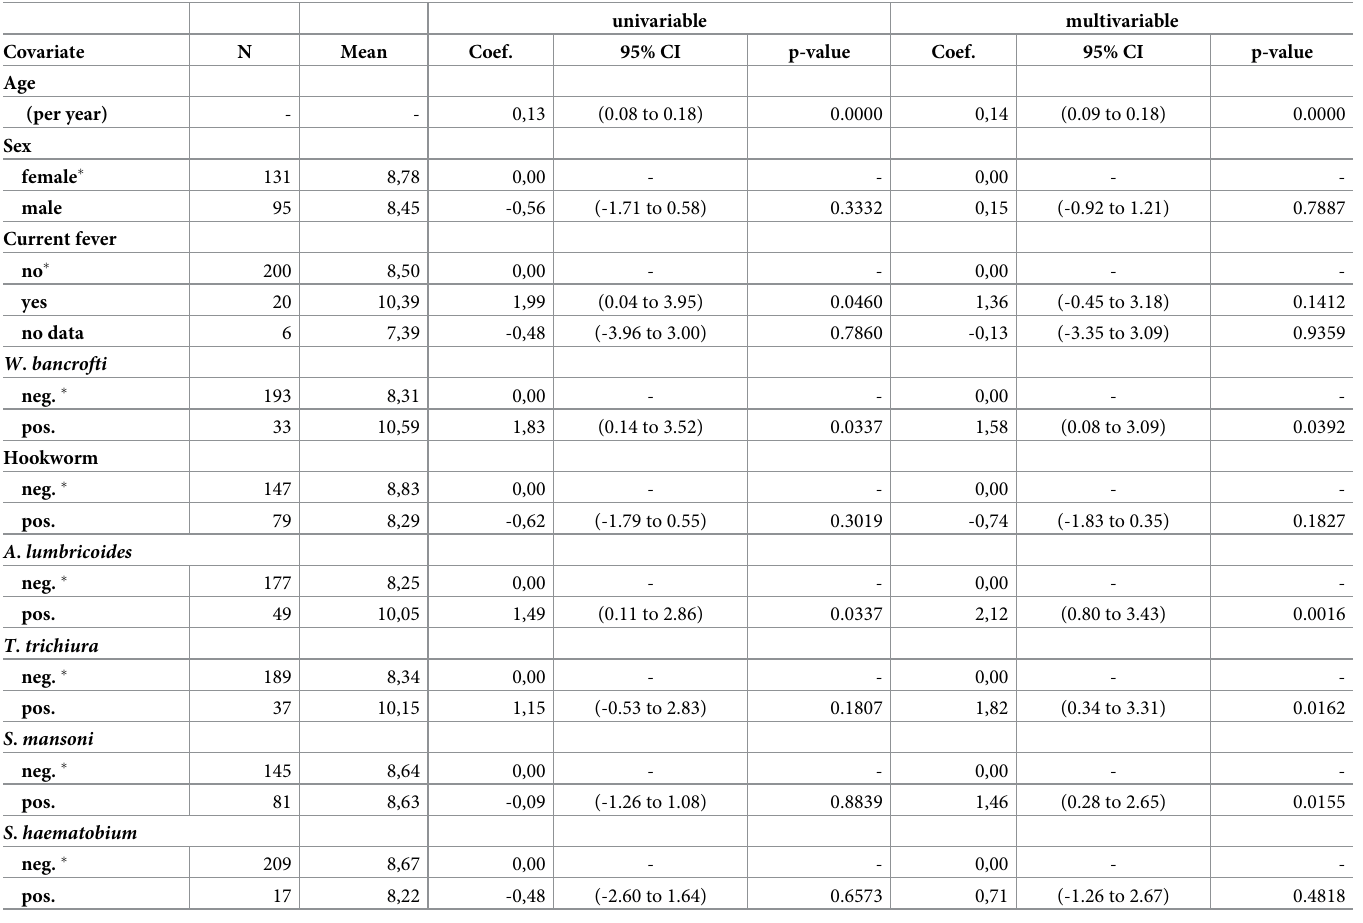
Table 2. Association of helminth infections with percent of HLA-DR pos CD4 T cells. Uni- and multi-variable mixed-effects linear regression results, with random effect for residence in Kyela site, multivariable results adjusted for all variables